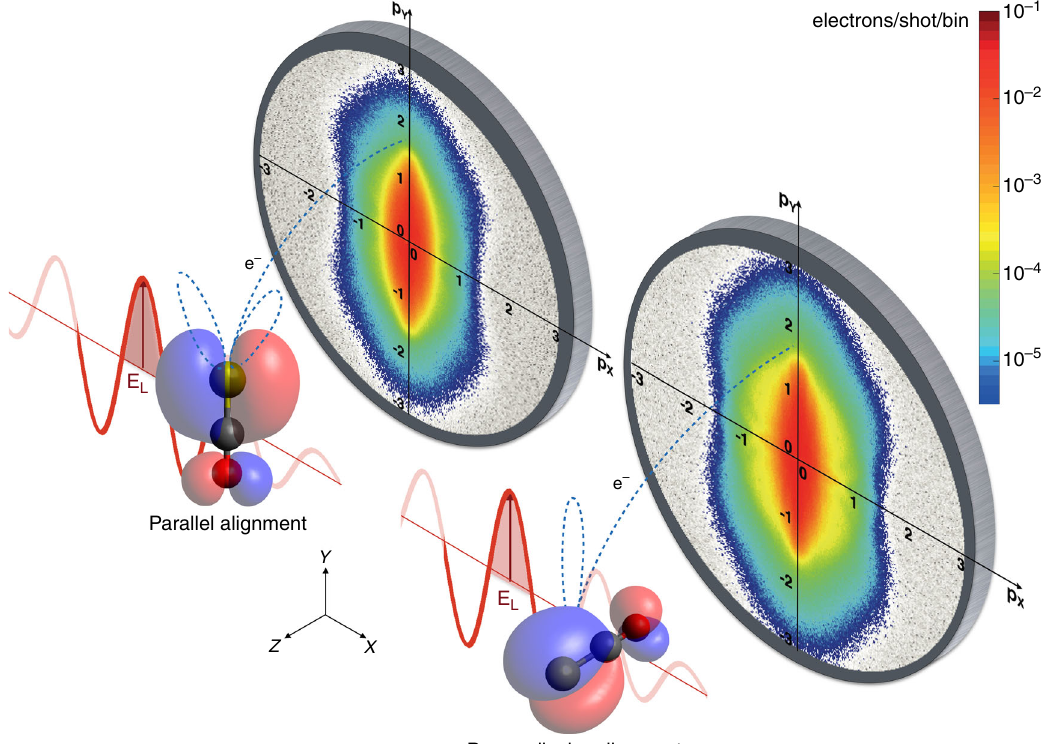
Fig. 1 Sketch of the experimental arrangement. OCS molecules (O in red, C in black, S in yellow) were aligned in the laboratory frame, parallel and perpendicular to the Y axis. The ionising laser electric fi eld ( E L ) was linearly polarised along the Y axis and the detection was in the XY plane. The molecular-frame angle-resolved photoelectron spectra were projected onto a 2D detector in a velocity map-imaging spectrometer. The alignment- dependent photoelectron trajectories are pictorially shown (blue dashed lines), as well as the corresponding shape of the ionising orbital (blue and red lobes). The spectra are displayed on a logarithmic intensity scale in units of